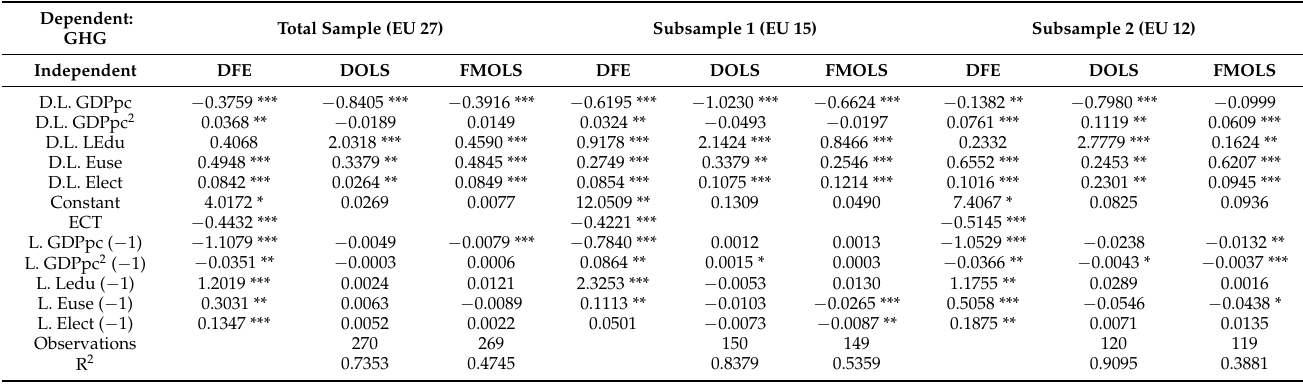
Table 5. DFE, DOLS, and FMOLS results for the total sample (EU-27), subsample 1 (EU-15), subsample 2 (EU-12) regarding Equation (1).